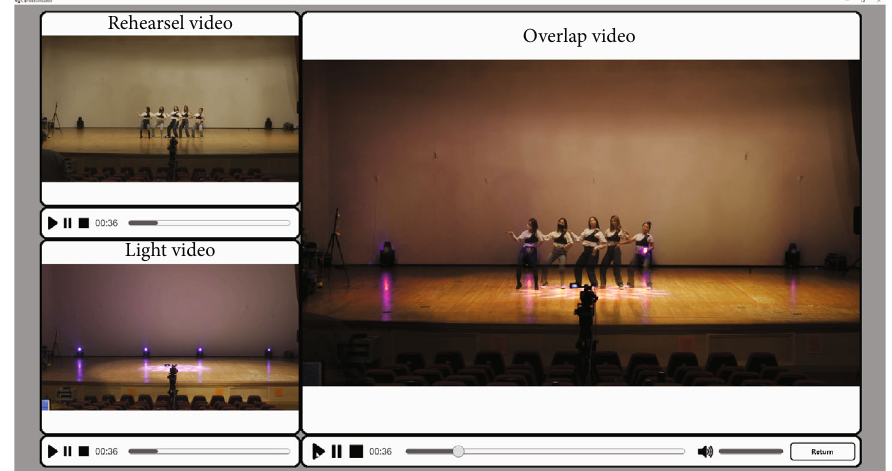
Figure 11: Simulator technology that can evaluate lighting e ff ects by overlapping rehearsal and simulated